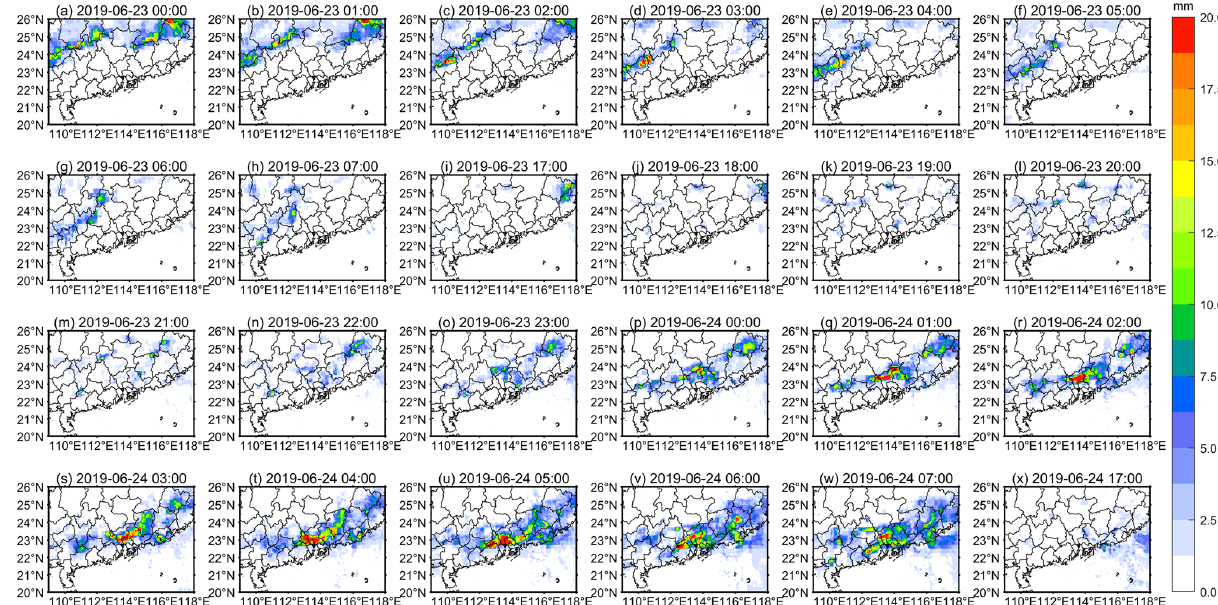
Figure 7. Estimated precipitation of the NQPE algorithm at (a–h) 00:00–07:00CST on 23 June, (i–o) 17:00–23:00CST on 23 June, (p– w) 00:00–07:00CST on 24 June and (x) 17:00CST on 24 June.